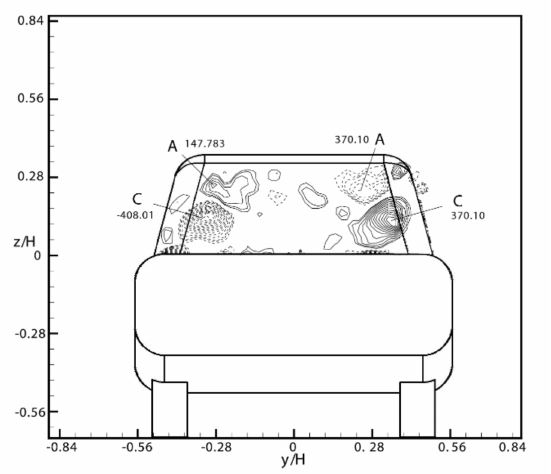
Figure 5. Iso-contours of time-averaged stream-wise vorticity, ω x in the y–z plane at x/H = − 0.39. Minimum and incremental values of vorticity are ω x,min = − 46.747 s − 1 , 48.778 s − 1 , and − 1 , ∆ ω x = 28.748 s